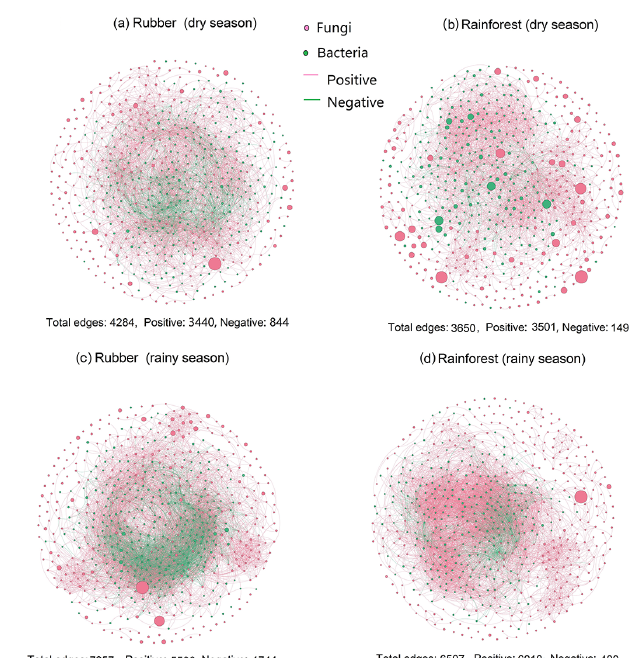
Figure 1. The soil bacterial–fungal community network of rubber plantations and rainforests in the dry and rainy seasons. Red solid circles indicate fungi, and green solid circles indicate bacteria. Red lines indicate a positive correlation between OTUs, and green lines indicate a negative correlation. The absolute value of the correlation coefficient ρ > 0 . 6 ( P < 0 . 01).